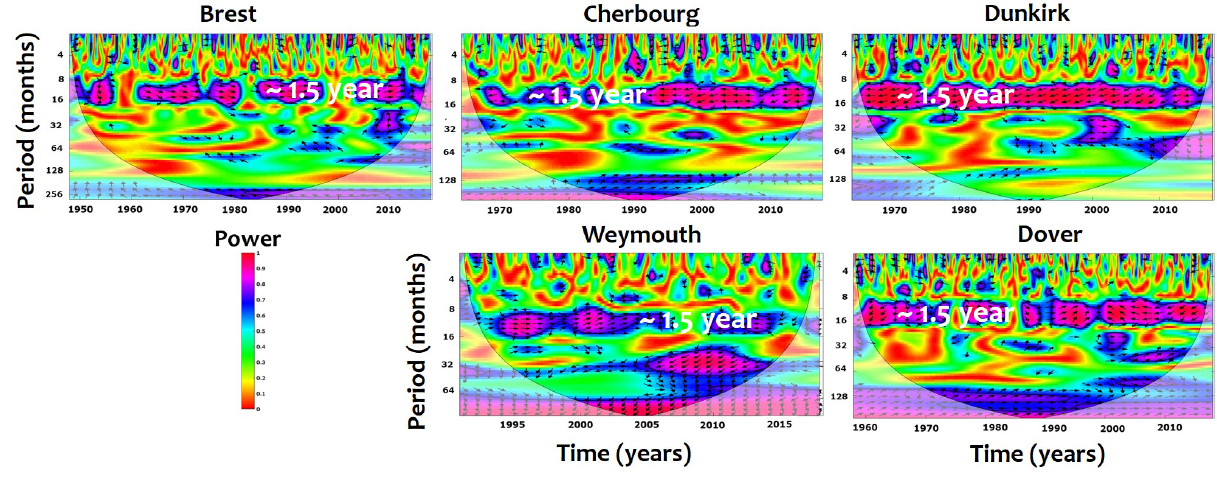
Figure 5. Cross-wavelet correlations between monthly extrema of surges and sea level pressure (SLP).